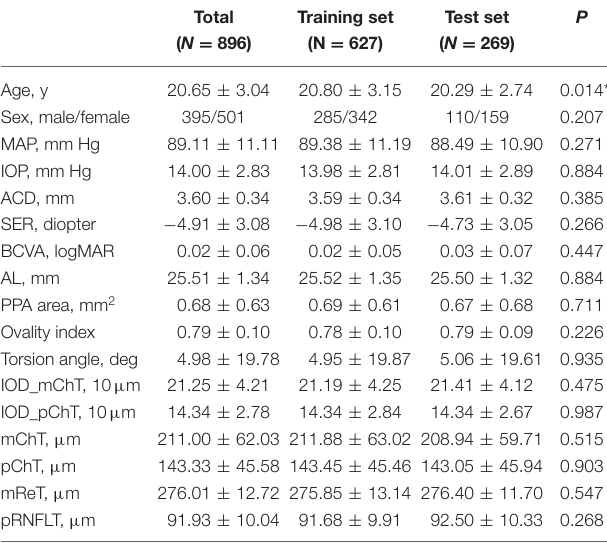
TABLE 1 | Demographic and ocular characteristics of the training and test sets.